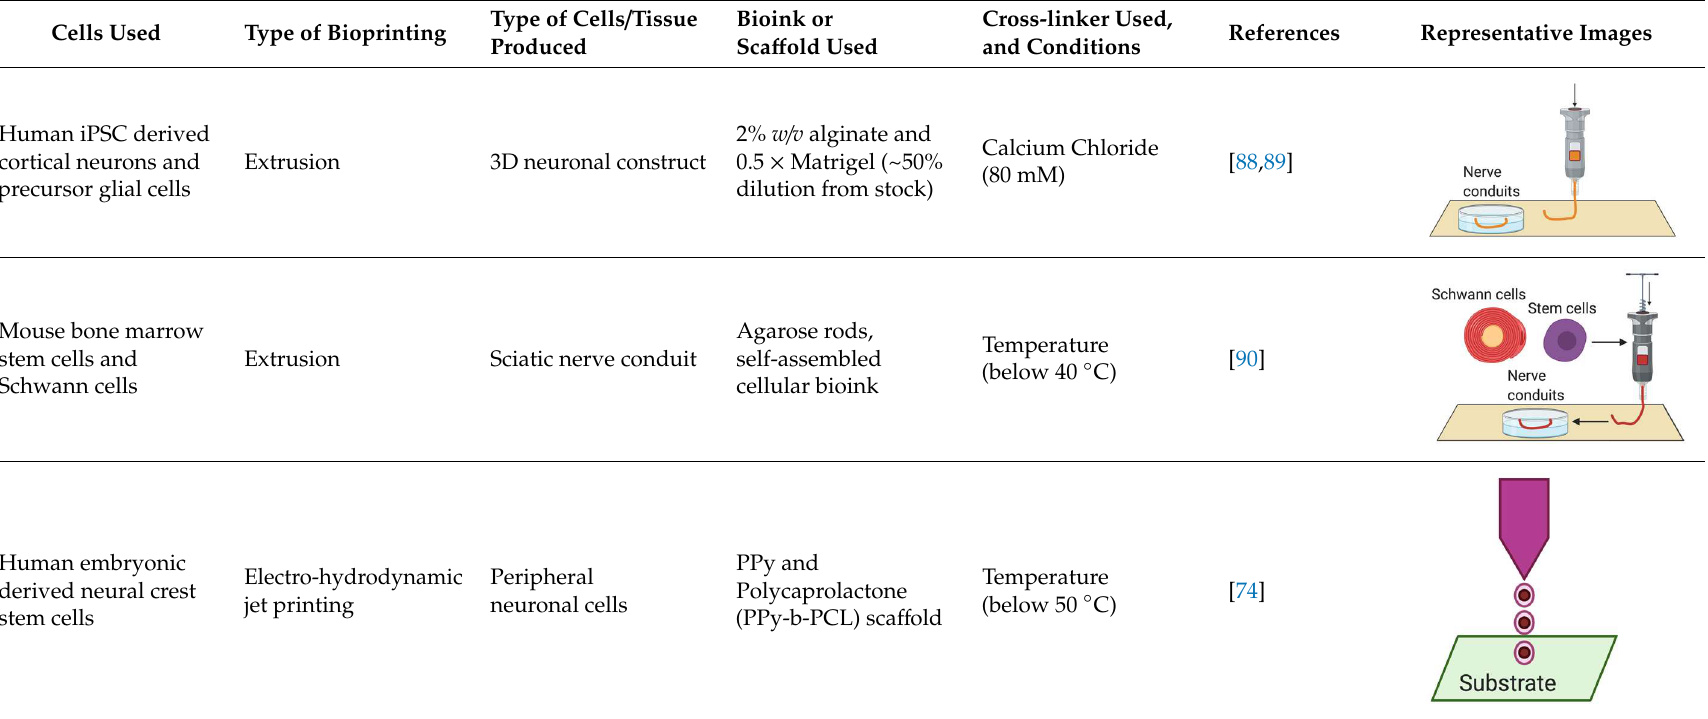
Table 1. Bioprinting of nerve conduits.